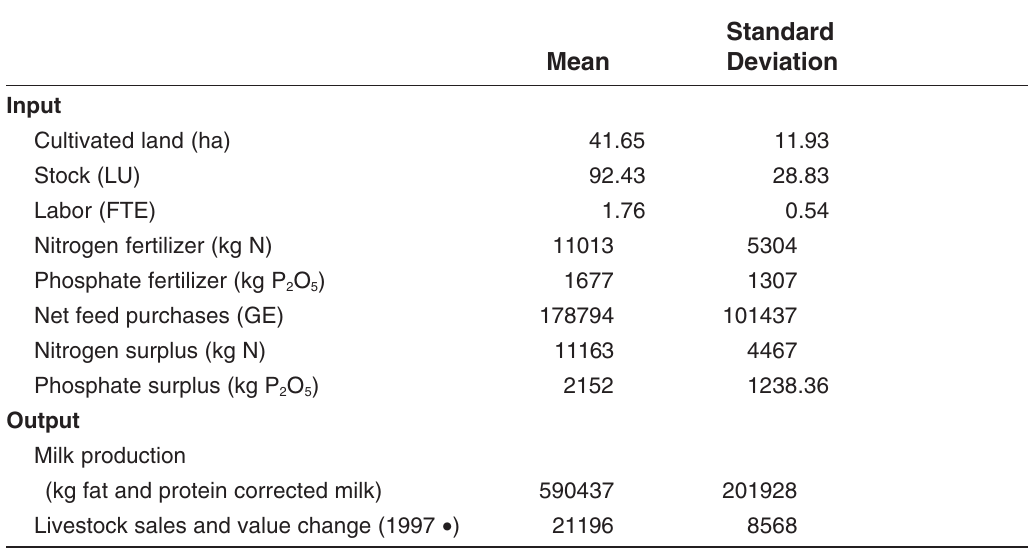
3-Year Averages and Standard Deviation of Total Inputs and Total Outputs*